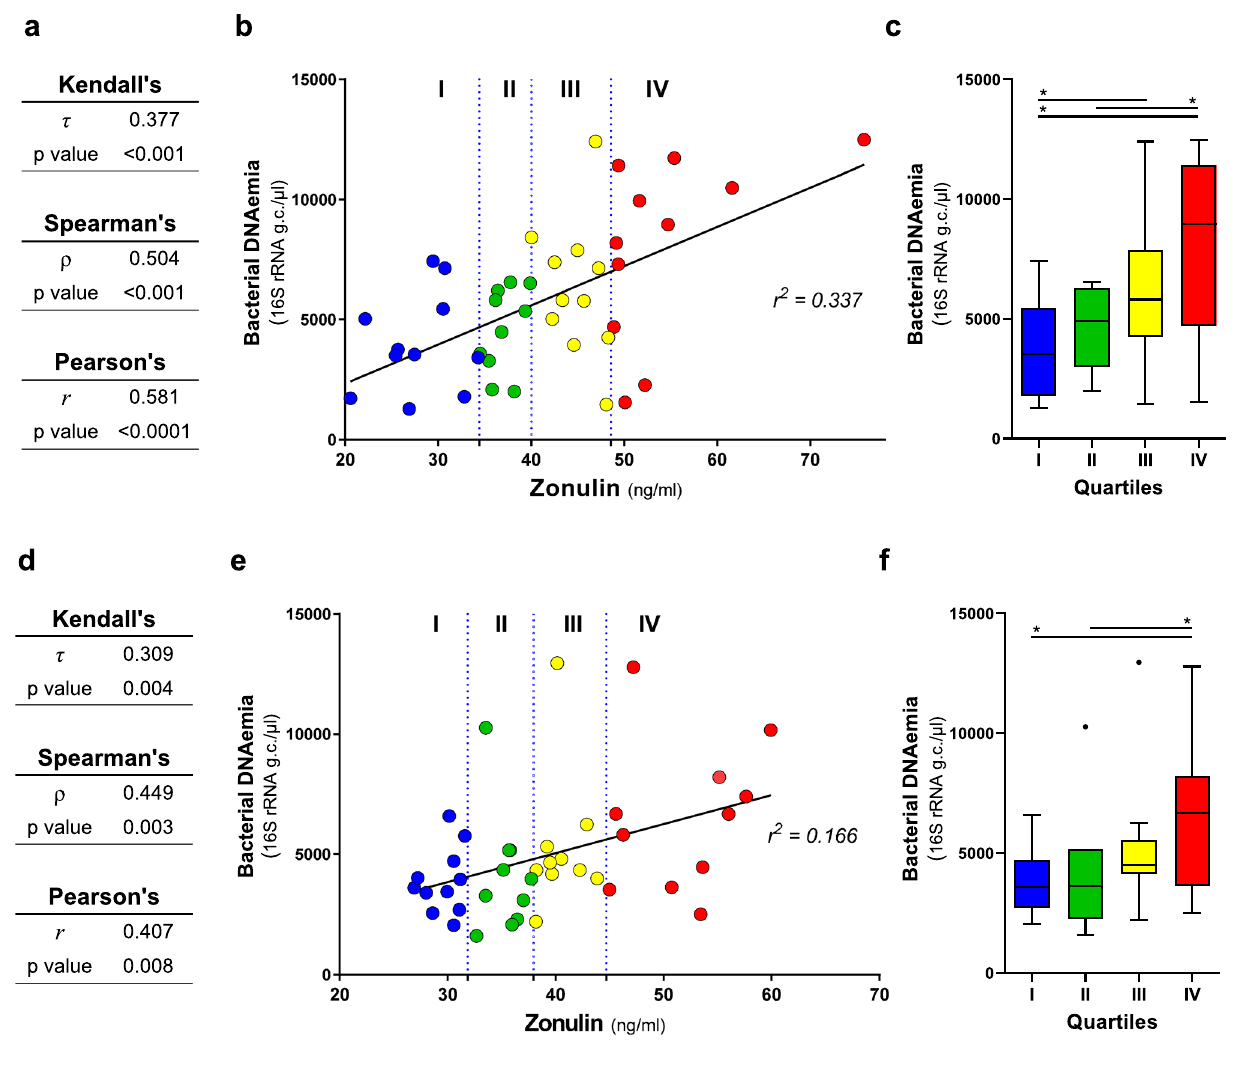
Figure 3. Linear regression and correlation analysis carried out between blood bacterial load and serum zonulin levels. Correlation has been assessed through Pearson’s ( r coefficient), Spearman’s (ρ), and Kendall’s (τ) analyses. Analyses were performed on the first (n = 43, panels A , B,C ) and the second (n = 42, panel D , E,F ) set of blood samples collected from older people. The second set of blood samples was collected approximately four months after the first draw from the same older volunteers. Panels A and D, tables showing correlation and regression indexes and p values. Panels B and E, linear regression plot; vertical dotted lines indicate the quartiles. Panels C and F, Tukey box plots showing levels of bacterial DNAema in blood samples grouped in quartiles based on zonulin